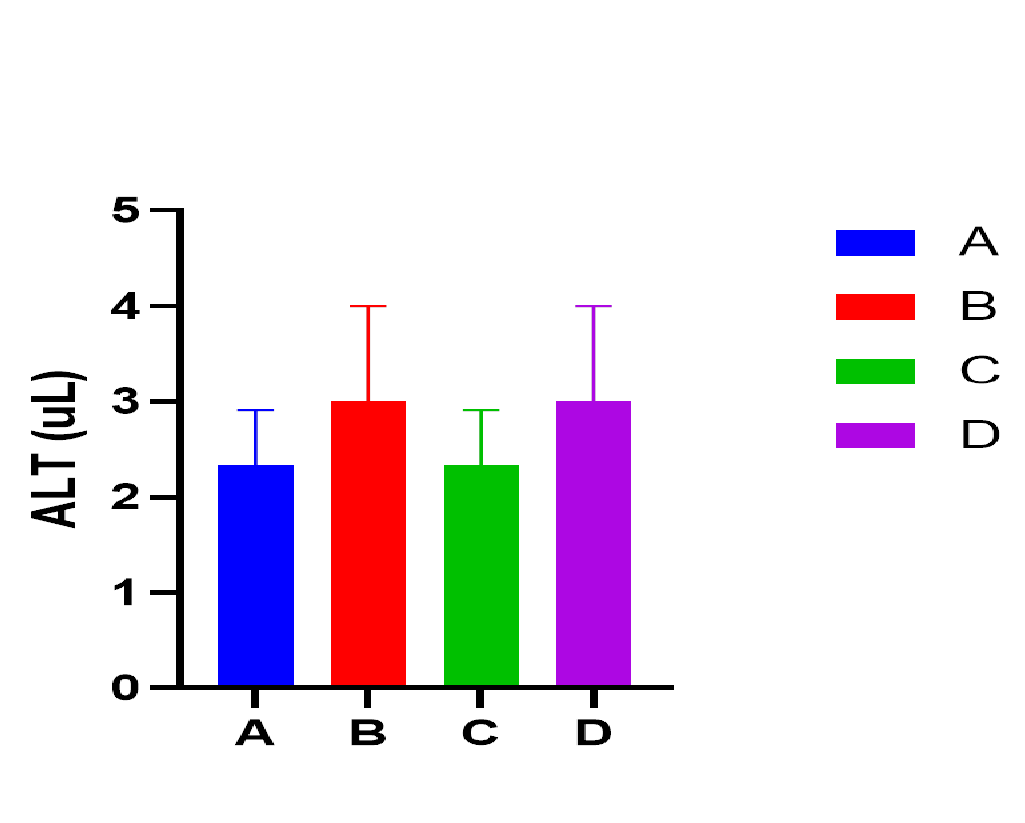
Key: A = T B = T C= T D = T C, 1, 2, 3